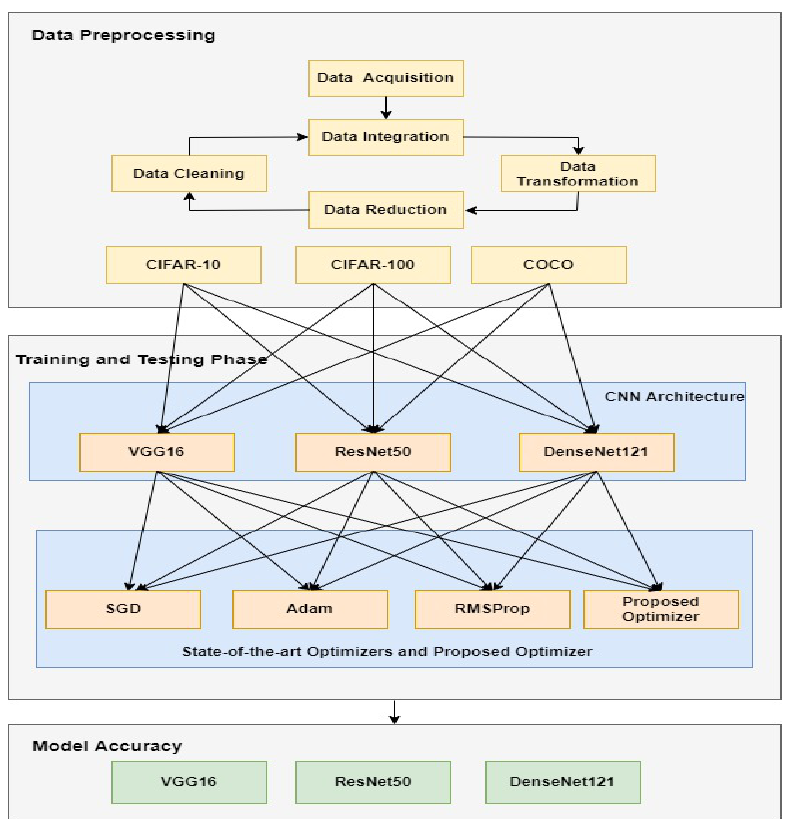
Figure 1. Overview of the proposed